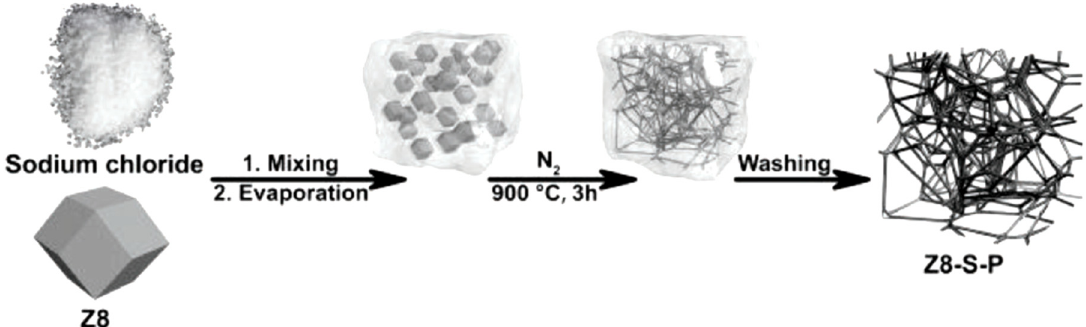
Figure 3. Schematic synthesis of an interconnected hierarchically porous carbon catalyst (Z8-S-P) by pyrolysis of an NaCl / ZIF-8 (zeolitic imidazolate framework 8) composite. Reprinted with permission from ref. [60]. Copyright (2018) John Wiley and Sons.